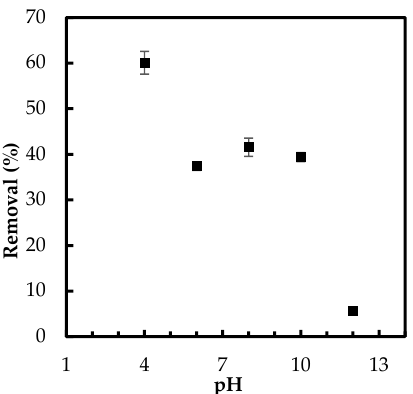
Figure 5. Effect of pH on phosphate removal by Zn(II)–CTS complex (Experimental conditions: 0.5 g/L adsorbent dose; 5 mg/L initial phosphate concentration).